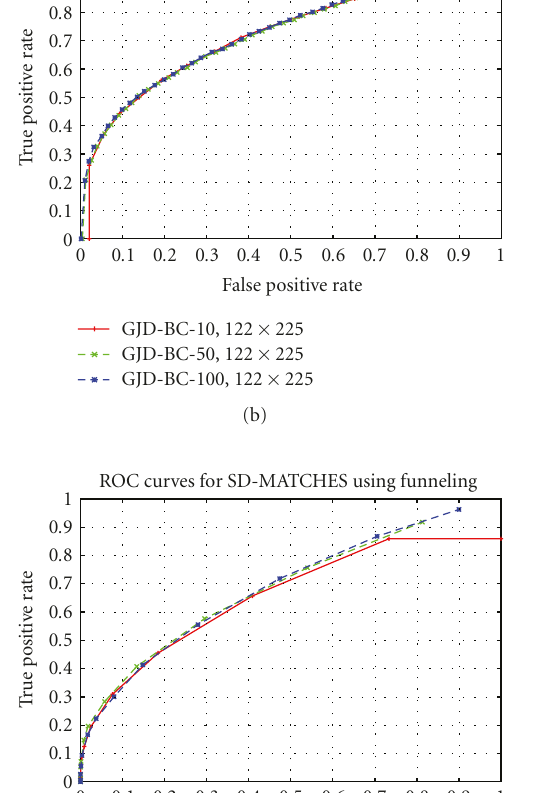
Figure 9: ROC curves of the best working variant of each method. Experiments were performed on faces aligned using